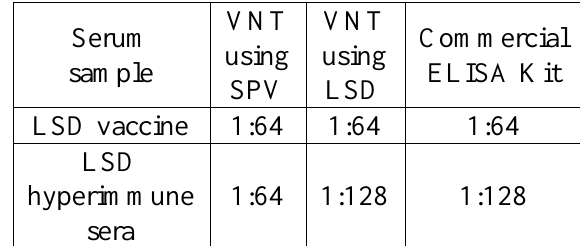
Table 4: Sensitivity of the VNT using SPV and LSDV as defined by the highest dilution giving positive test results in comparison with the commercial ELISA kit.